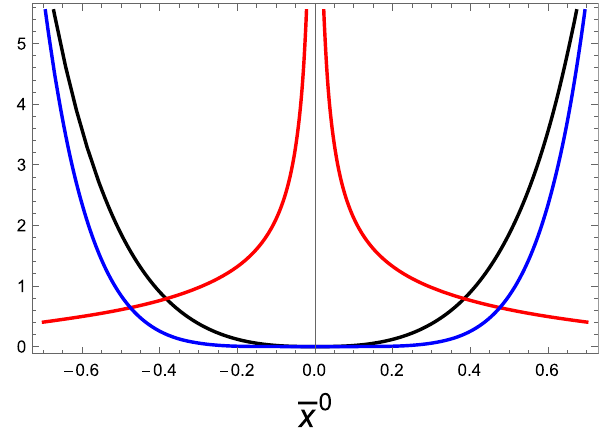
Fig. 4 Time evolution of the scale factor a (black), the speed of light c (red) and the gravitational constant G (blue) for ¯ x 0 < 0 and ¯ x 0 > 0